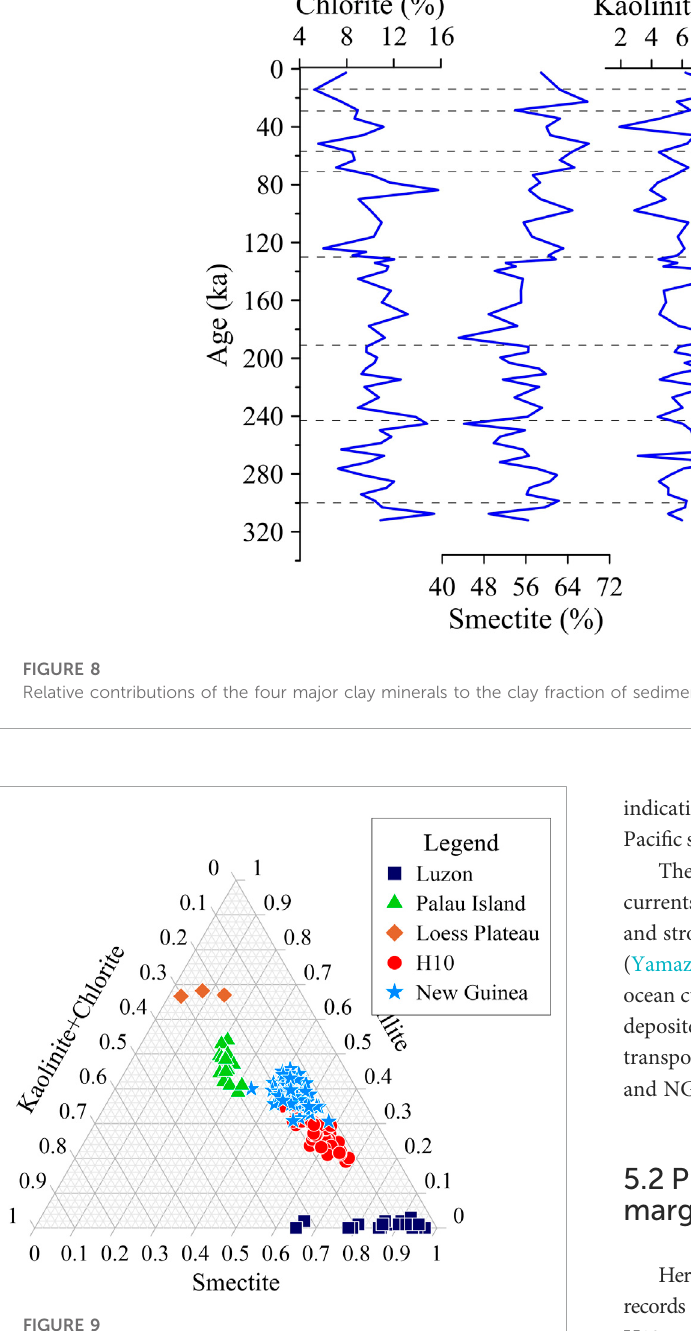
FIGURE 9 Ternary diagram of the clay mineralogy of core H10 sediments. Potential source areas: Luzon Island (Liu et al., 2009), Palau Island (Seo et al., 2014), China ’ s Loess Plateau (Kalm et al., 1996; Shi et al., 2005), and New Guinea (Howell et al., 2014; Liu et al.,